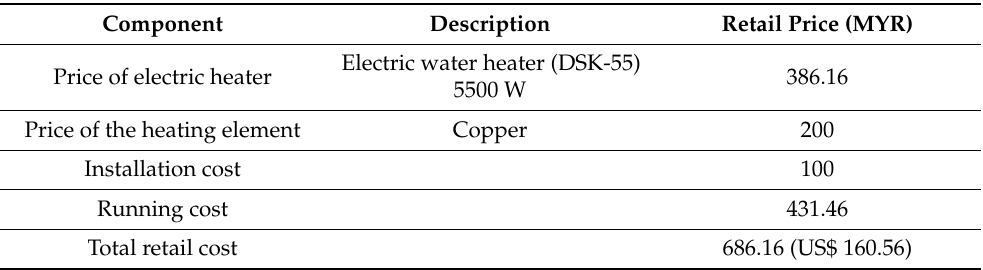
Table A3. Cost of all components for constructing electric heater. Reprinted/adapted with